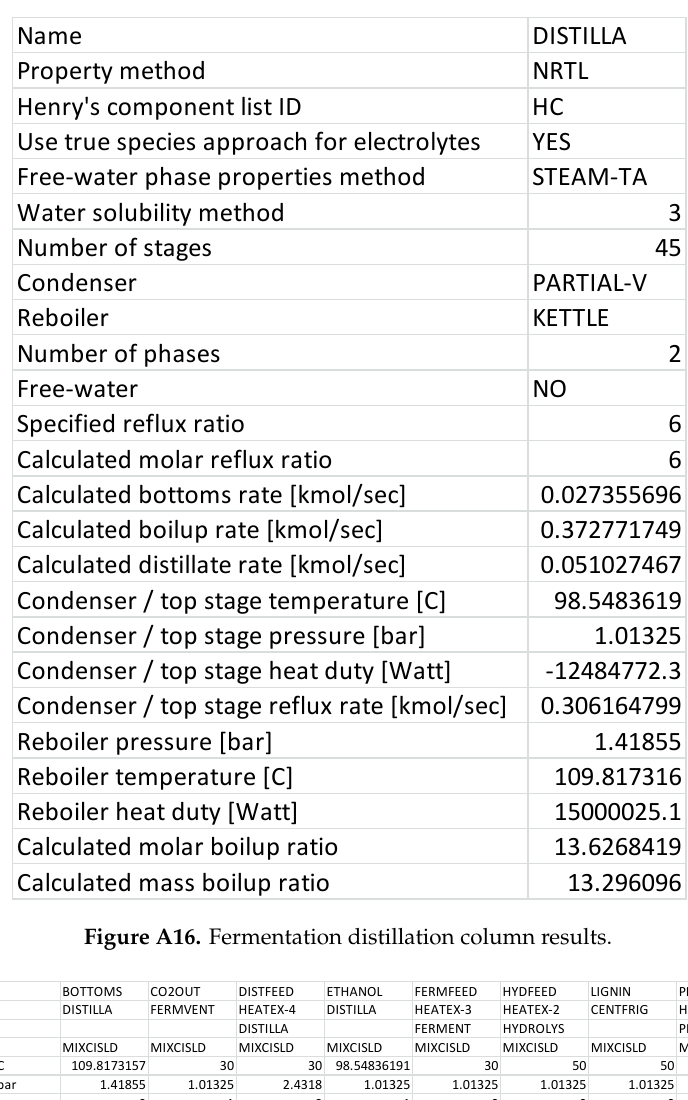
Figure A15. Fermentation ferment, hydrolys, pretreat reactor results.